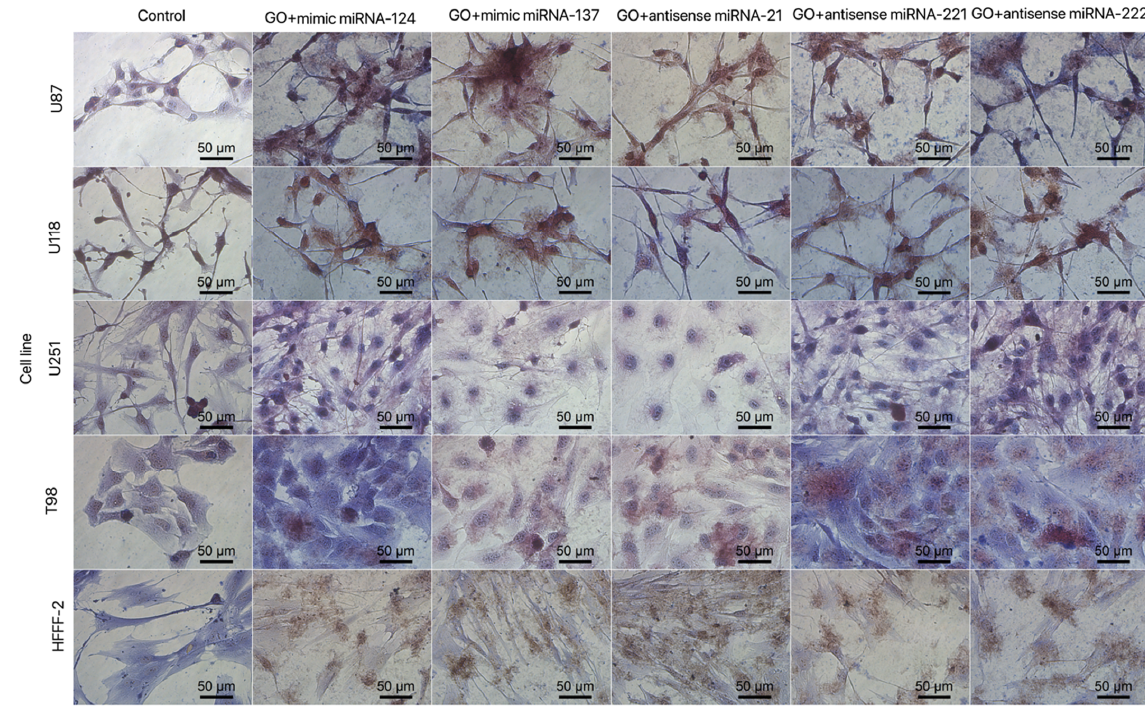
Figure 13. Morphology of U87, U118, U251 and T98 glioblastoma and HFFF-2 cells treated with GO + mimic miRNA-124, GO + mimic miRNA-137, GO + antisense miRNA-21, GO + antisense miRNA-221 and GO + antisense miRNA-222. Abbreviations: GO: graphene oxide. Scale bars: 50 µm.